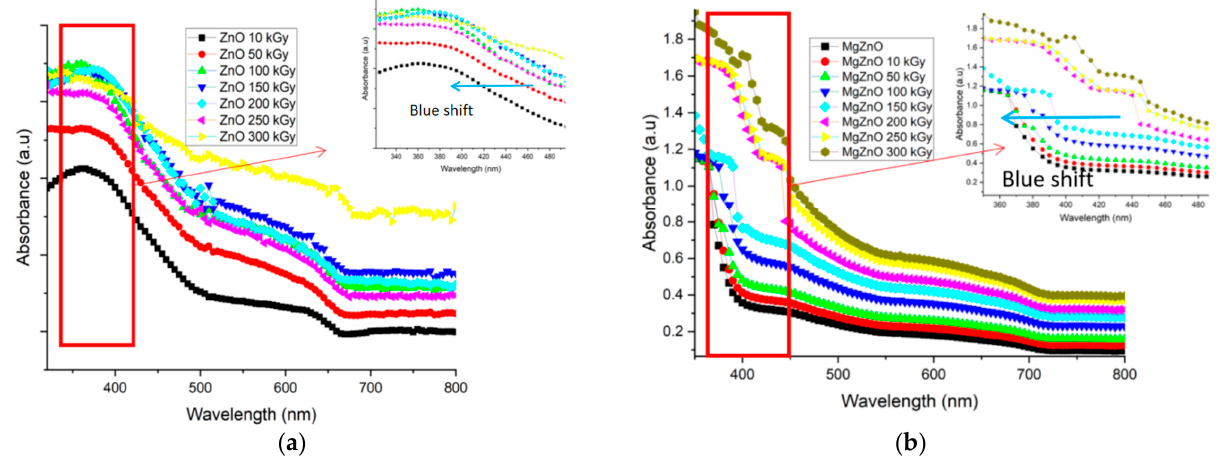
Figure 4. Absorbance Spectra with increasing TID of ( a ) ZnO and ( b ) MgZnO. In ZnO semiconductor, bandgap formation occurs by hybridizing a localized 3d electron from a zinc atom with a 2p electron from an oxygen atom [5]. Figure 3c,d show that bandgap decreases with the increase in TID. Furthermore, an increase in lattice strain and the decrease in grain size crystallites with increasing TID suggest defects strongly associated with increased gamma radiation dose. Thus, the decrease in the band gap is closely associated to the structural defects observed in the structural analysis obtained in the XRD section, with the presence of cluster, cavities, surface roughness, etc. The decrease can also be attributed to the change in the Fermi level between the conduction and valence band [21].